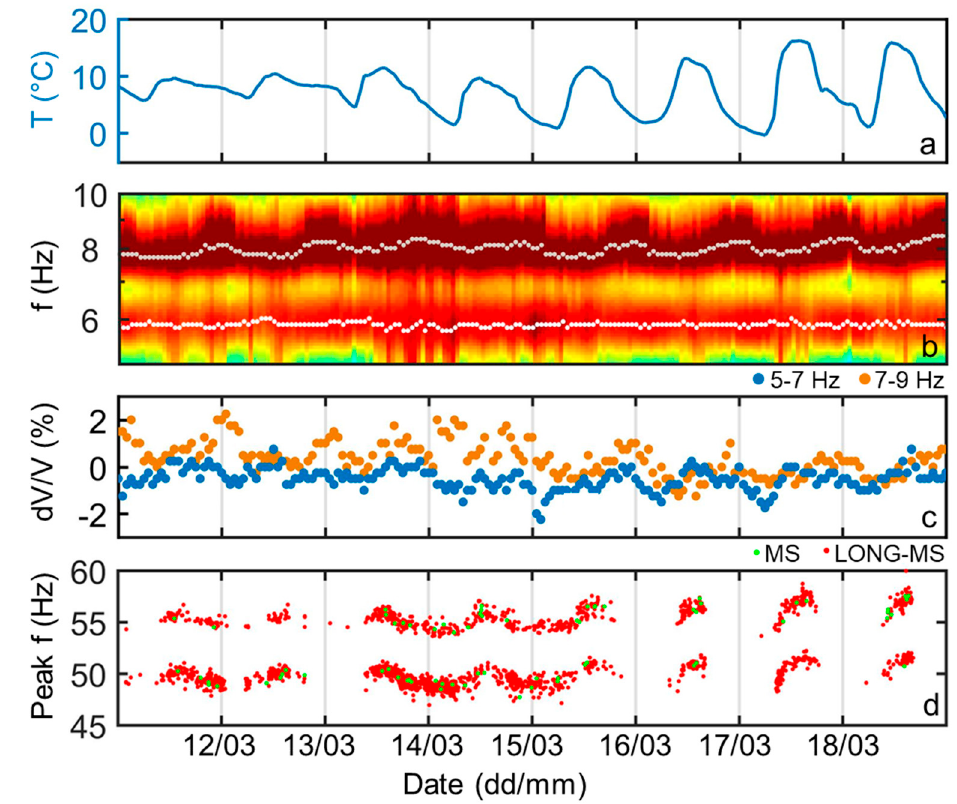
Figure 12. Zoom on daily seismic parameters variations in comparison with air temperature over an 8-day window (Mid-March 2020) without precipitation. ( a ) air temperature variations at the nearest ARPA Piemonte meteorological station of Ponte di Nava. ( b ) Zoom on H2/V2 spectral ratio around the first two resonance frequencies (same color scale of Figure 5c) with hourly f1 and f2 maxima highlighted by white and gray dots. ( c ) Seismic velocity changes retrieved from ambient noise cross-correlation in the frequency bands overlapping f1 and f2. ( d ) Peak frequency of the microseismic events recorded at S2.